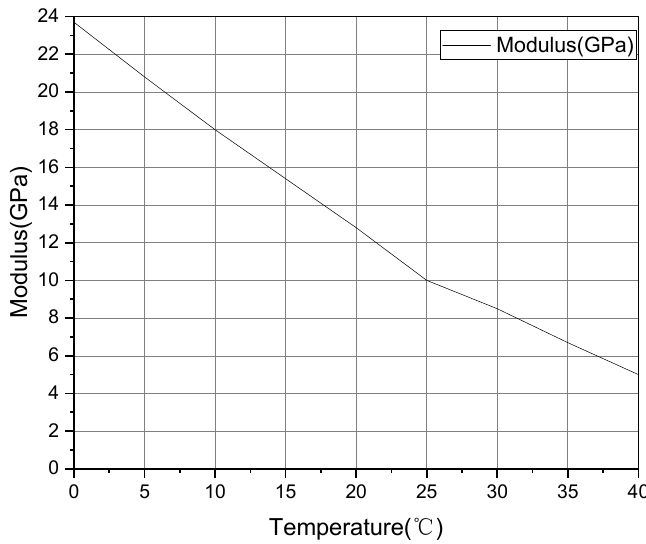
Figure 5. GSP Resilient Modulus Versus Temperature Design Curve.